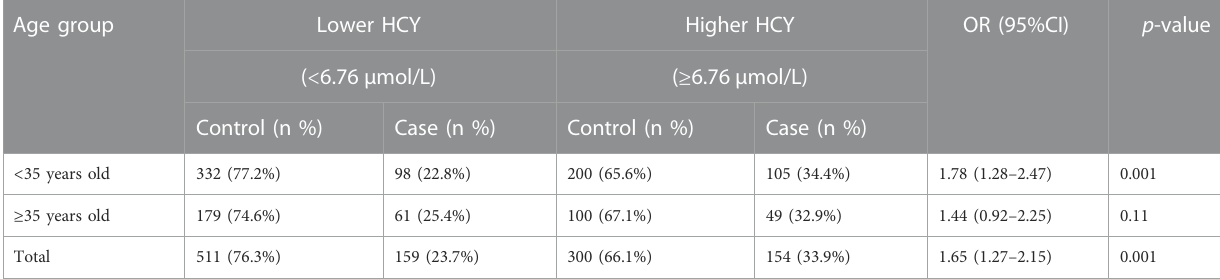
TABLE 4 HCY strati fi cation analysis in different age groups between case and control